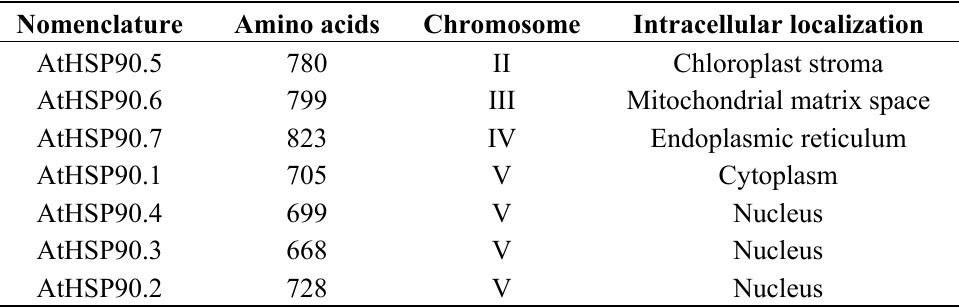
Table 2. Arabidopsis Hsp90